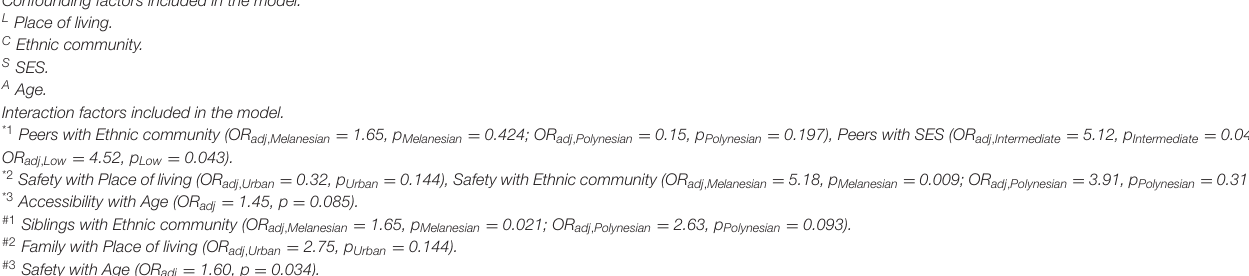
Accessibility OR, odds-ratio; OR adj , adjusted odds-ratio; CI, confidence interval. Confounding factors included in the model. L Place of living. C Ethnic community.